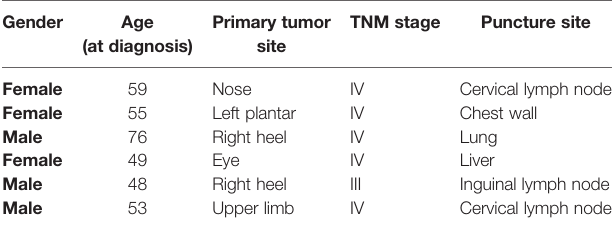
TABLE 1 | Clinical and pathological features of puncture melanoma patients in this study.